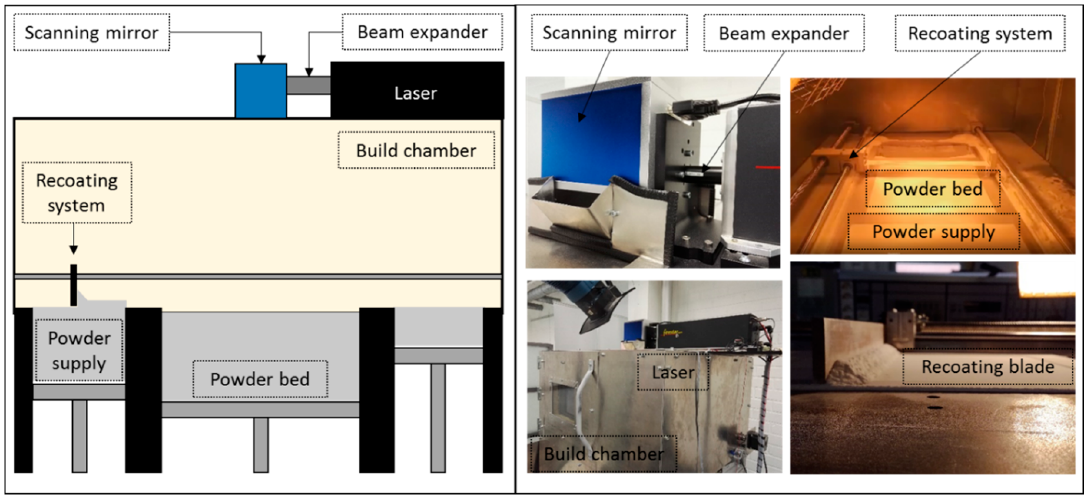
Figure 1. Open hardware and software PBF system.